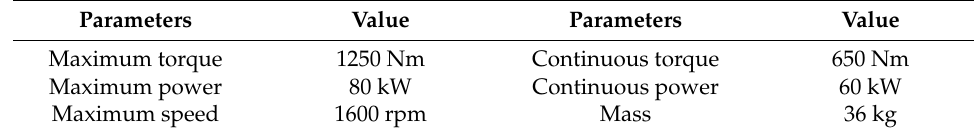
Table 2. IEM parameters.